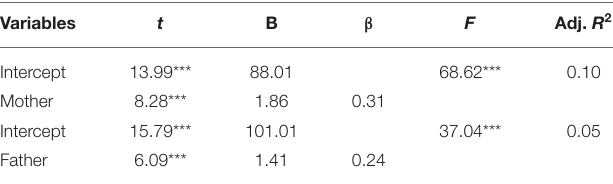
TABLE 6 | Linear regression analysis of perceived parenting of mothers and fathers on self-concept ( N = 628). Variables